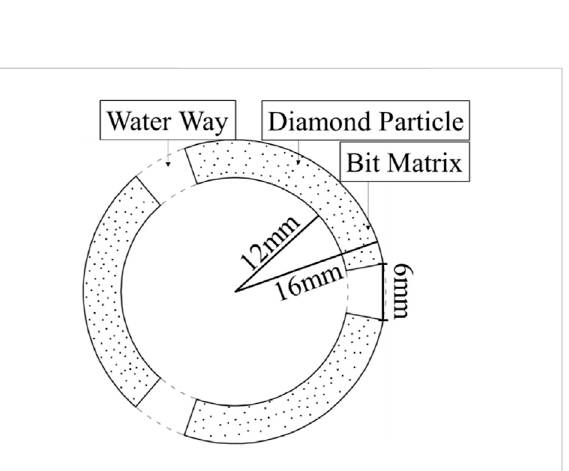
FIGURE 6 Diamond impregnated